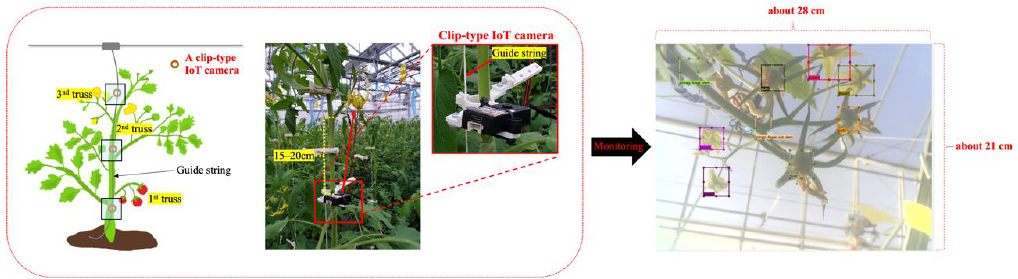
Figure 5. Installation of clip-type IoT cameras. IoT: Internet of Things.